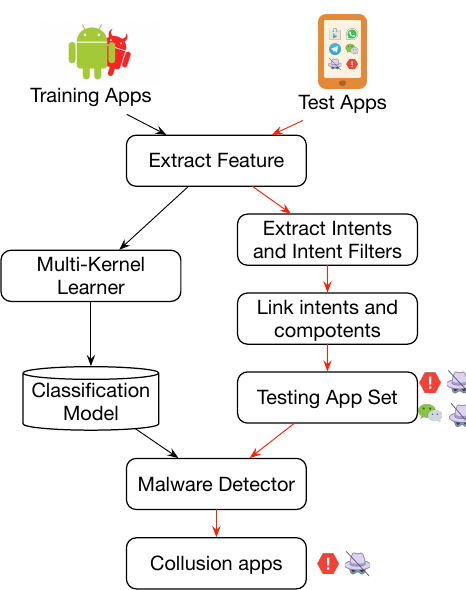
Figure 3. Architecture of